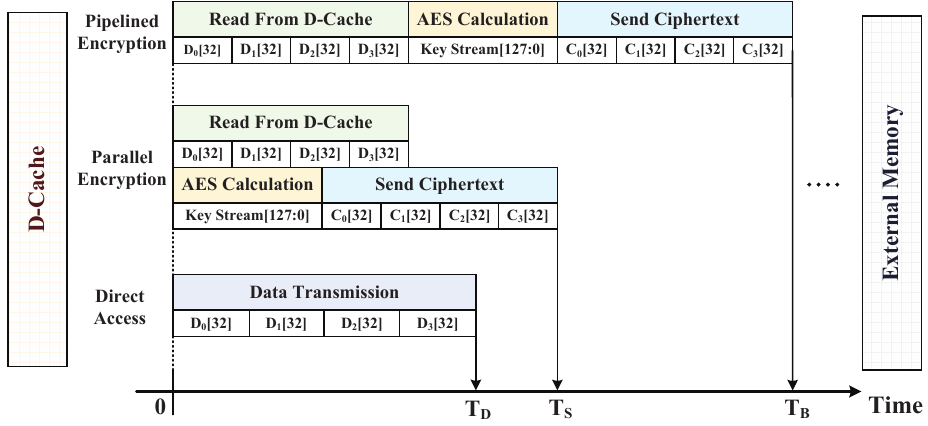
Figure 9. Time consumption comparison of the three different methods for completing a write-back operation from